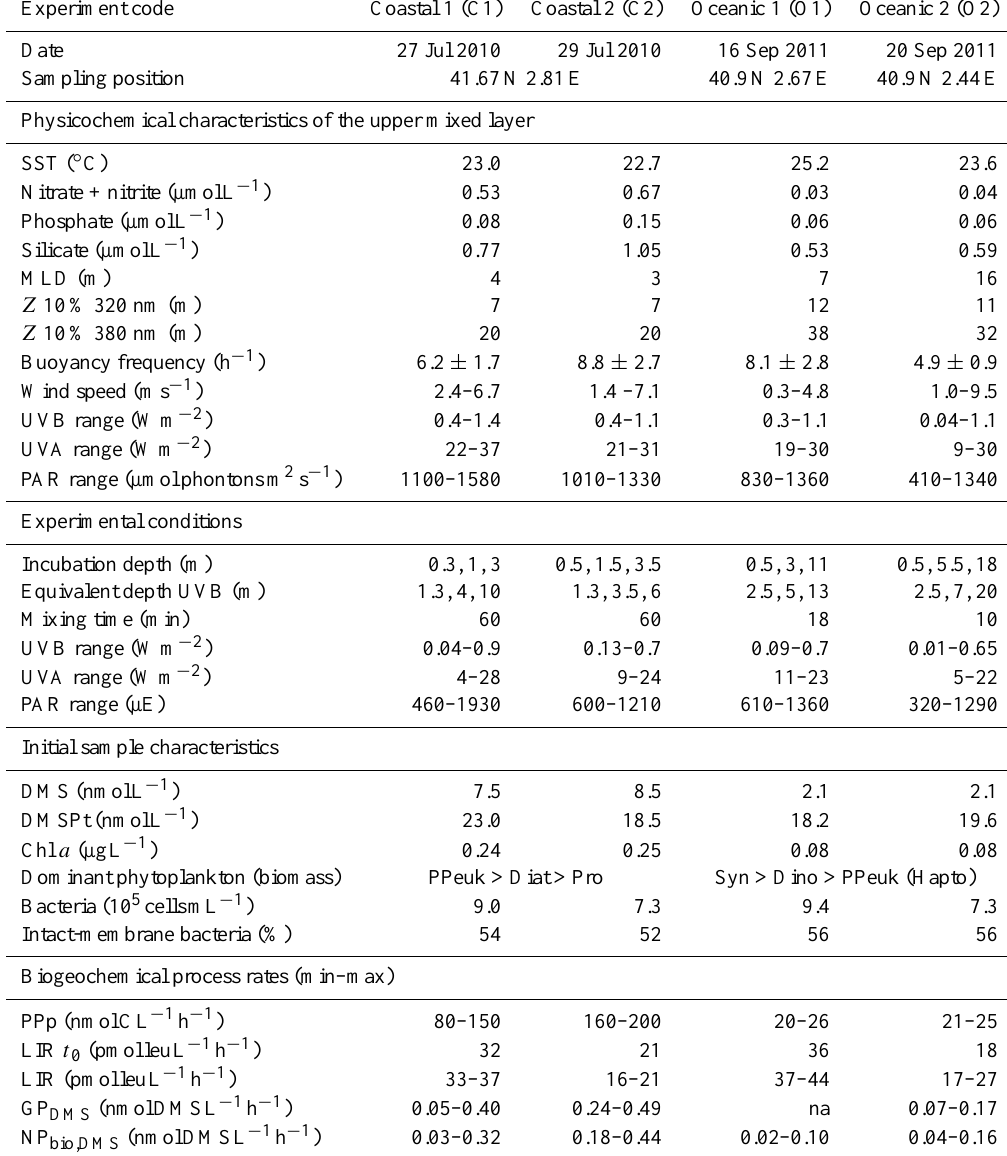
Table 1. Summary of initial sample characteristics, ecosystem settings and experimental conditions. Phytoplankton group dominance is indicated in a qualitative manner, with biomass calculations made following Simó et al. (2009). All biogeochemical process rates refer to the experimental incubation except for LIR t0, which correspond to the initial sample. GP DMS and NP bio,DMS stand for gross and net biological DMS production, respectively. Pro: Prochlorococcus ; Syn: Synechococcus ; PPeuk: photosynthetic picoeukaryotes; Diat: diatoms; Dino: dinoflagellates; Hapto: haptophytes; na: not available. See text for other